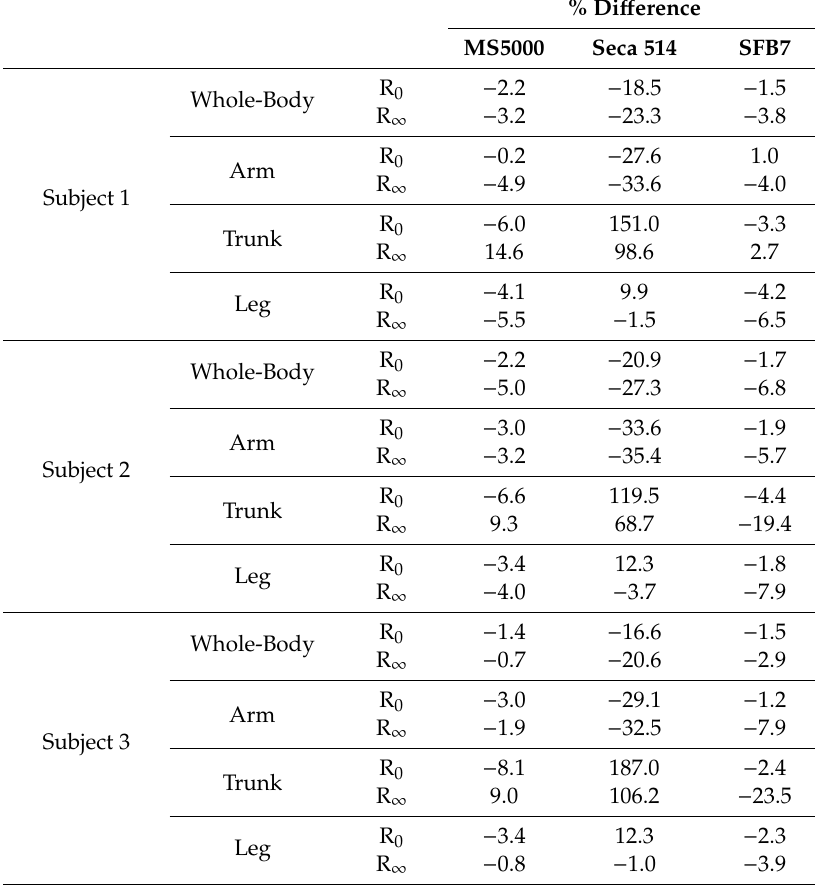
Table 2. Segmental measurement di ff erences versus SBISD